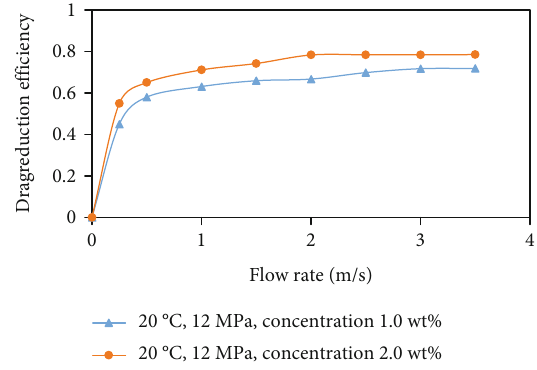
Figure 6: Flow rate versus drag reduction e ffi ciency at 20 ° C/12 MPa.